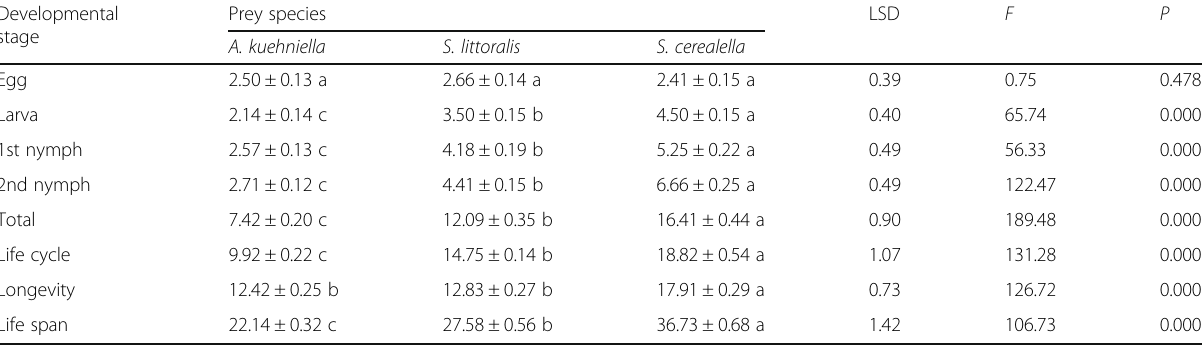
Table 2 Duration (in days) of male developmental stages of Neosiulus barkeri fed on eggs of Anagasta kuehniella , Spodoptera littoralis , and Sitotroga cerealella and incubated at 27 °C and 70% RH Developmental stage